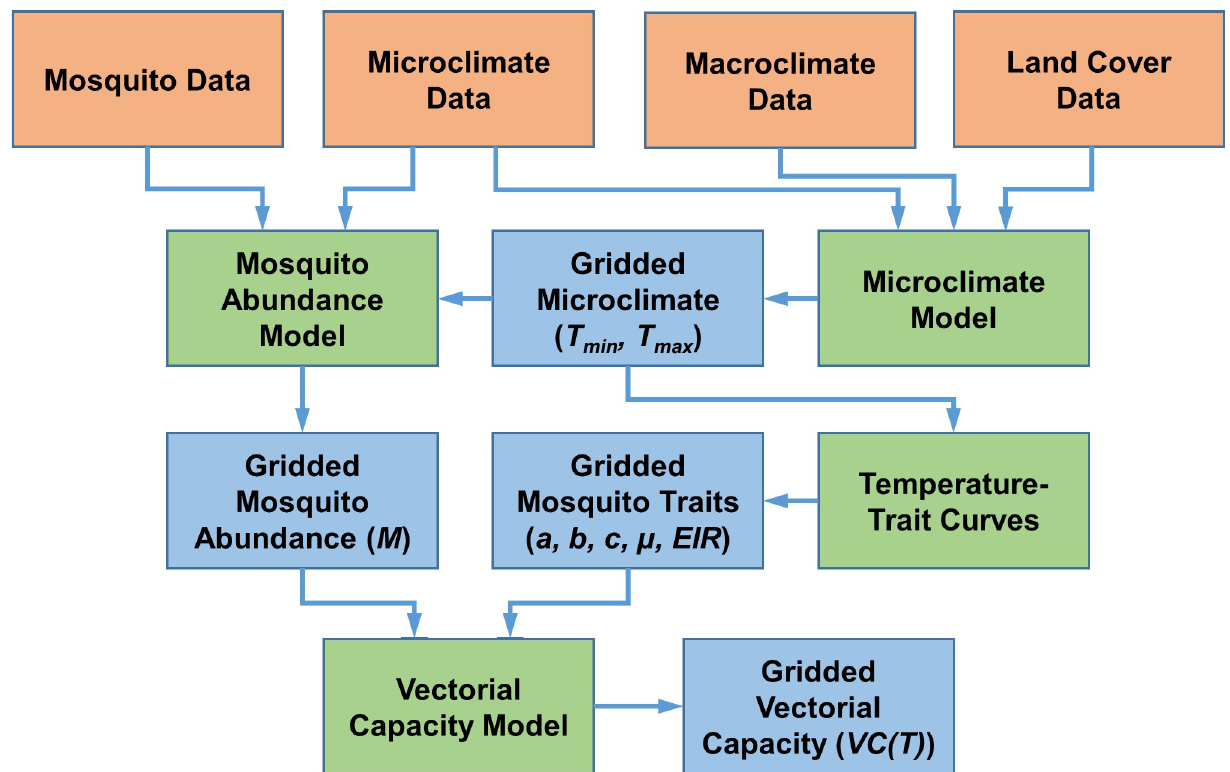
Fig 2. Analytical workflow for spatial modeling of microclimate temperatures and thermal potential for dengue transmission by Aedes albopictus . Orange boxes represent input datasets, green boxes represent models, and blue boxes represent model predictions.